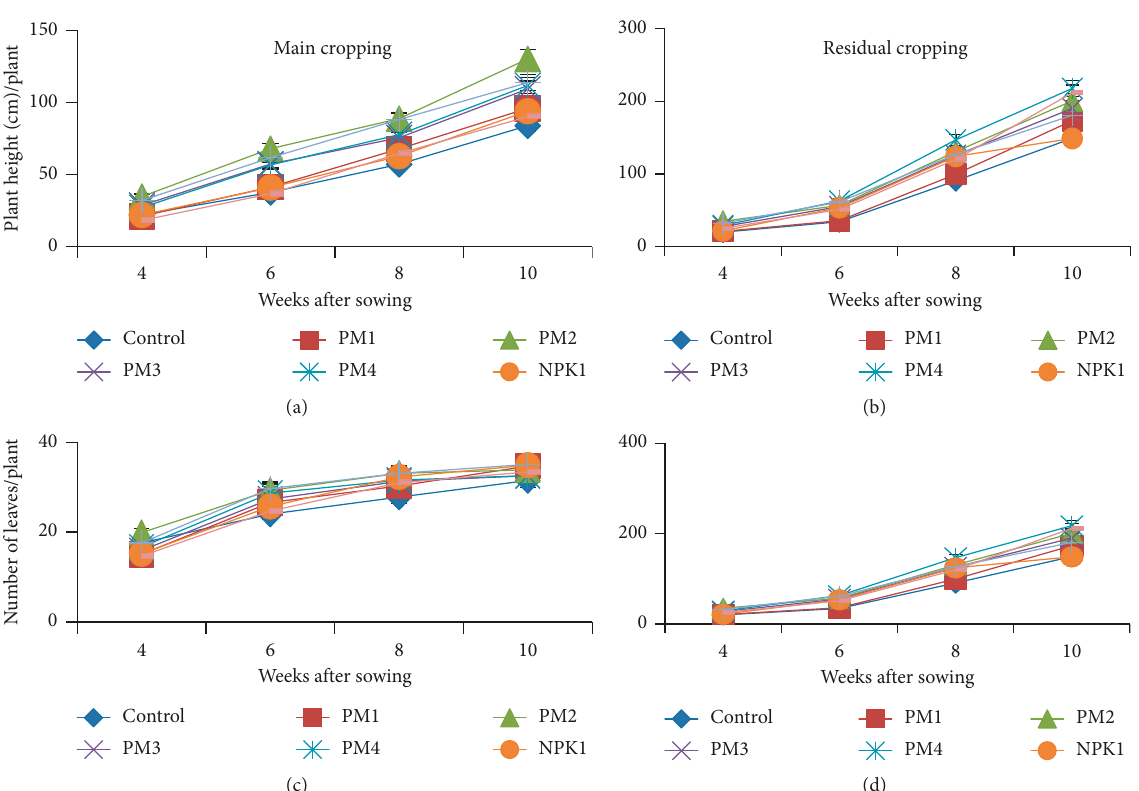
Table 1: Physical and chemical properties of the soil and chicken manure used for the experiment. Organic C Available P Chemical properties pH Soil Chicken manure Table 2: ANOVA table of effects of chicken manure and NPK on performance of sunflowers on ferruginous soil. Source of variation PH NLV Main cropping Treatments Mean SEM Residual cropping Treatments Mean